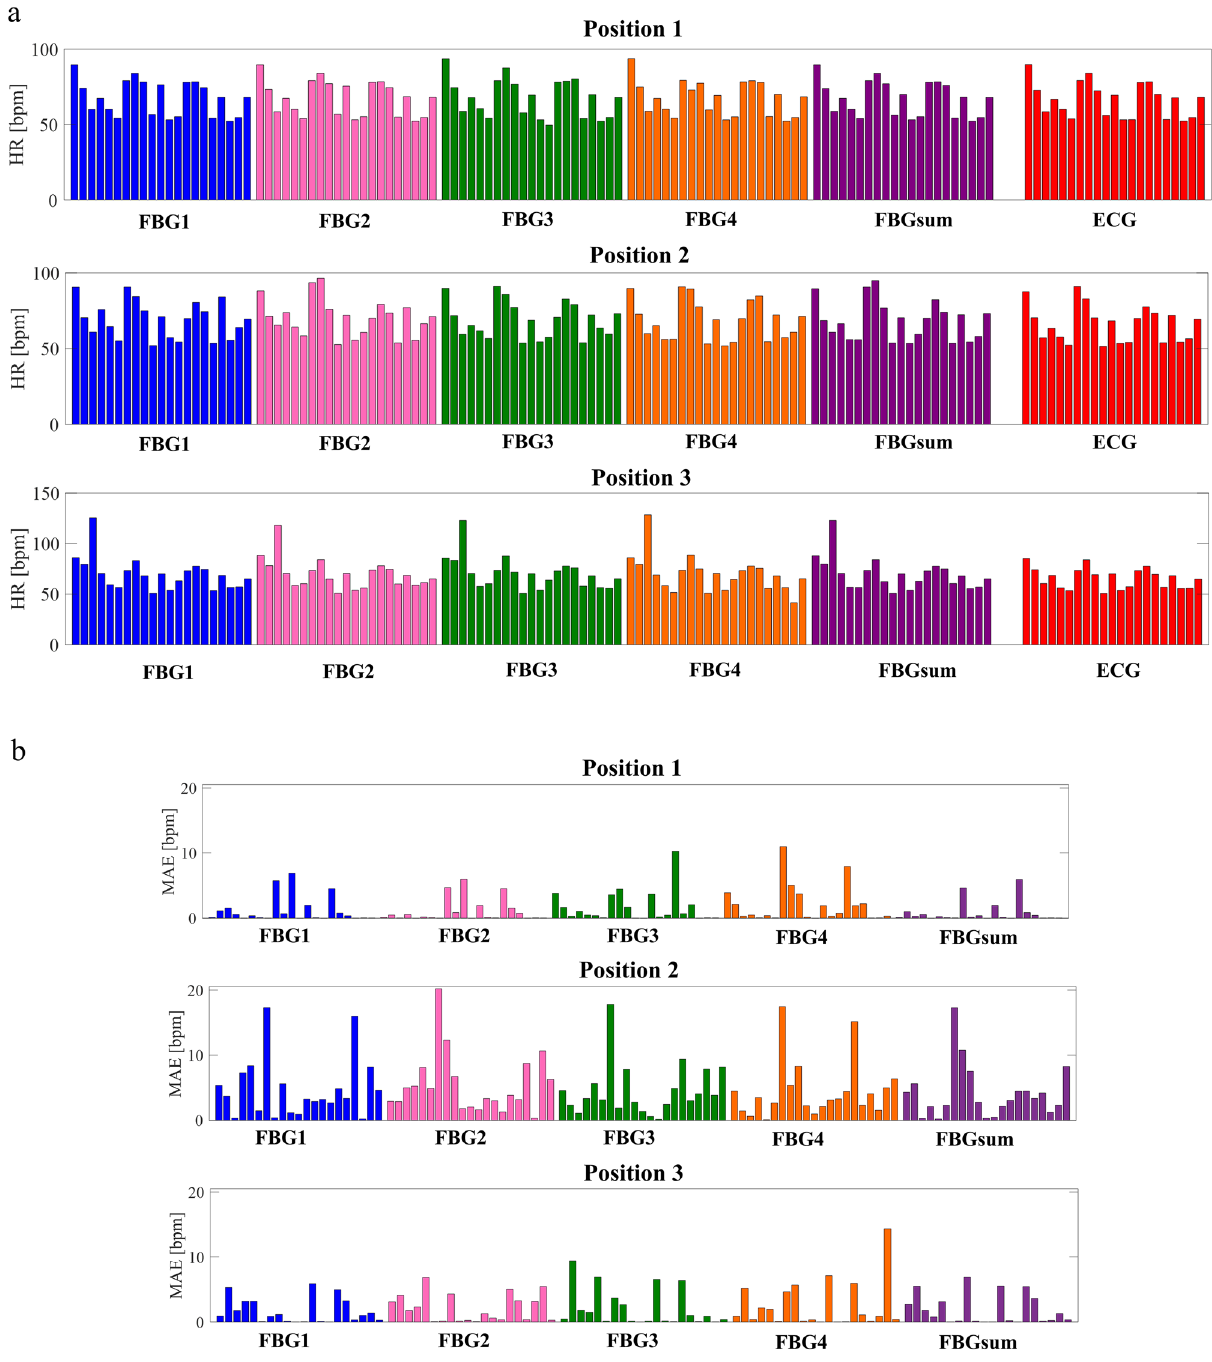
Figure 8. ( a ) The mean HR values obtained by the FBG1 (blue bars), FBG2 (magenta bars), FBG3 (green bars), FBG4 (orange bars), FBGsum (purple bars) considering the three positions, the three tests and the seven subjects. The reference values estimated by the ECG sensor (red bars) are also reported. ( b ) The MAE values obtained comparing each HR value estimated by the SWS considering FBG1, FBG2, FBG3, FBG4, and FBGsum with the reference